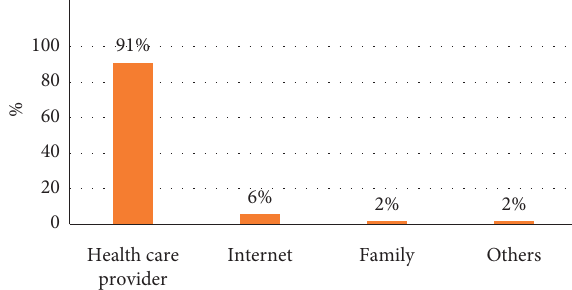
Figure 2: The most important sources of information regarding vaccinations reported by the surveyed